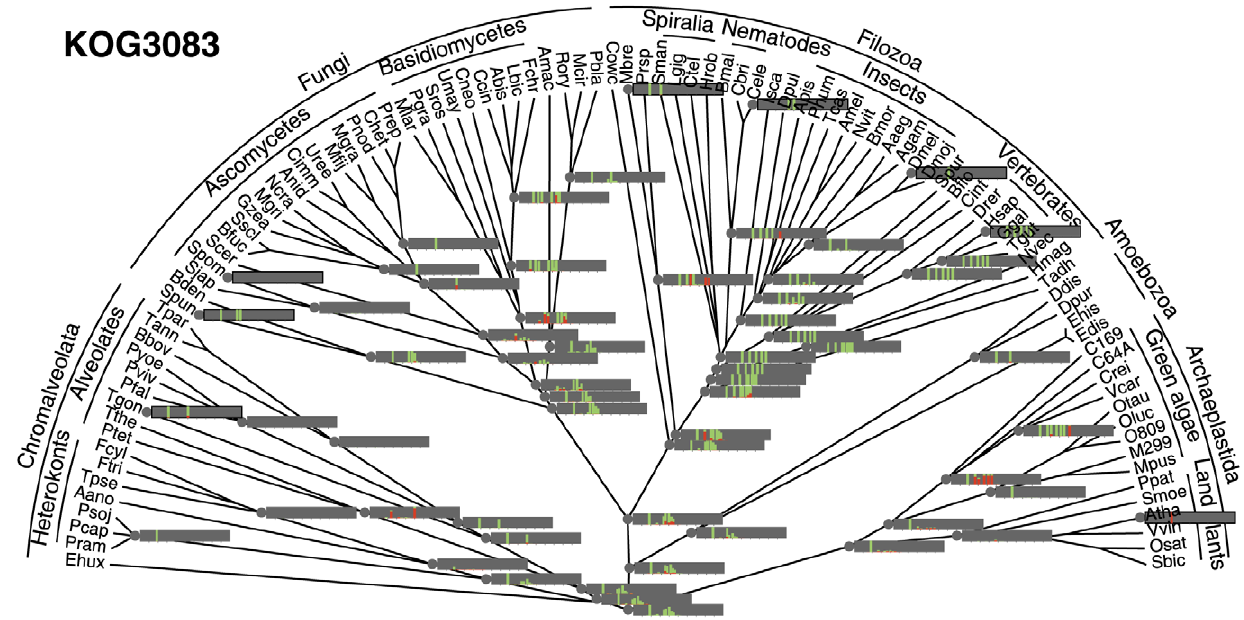
Figure 3. Inferred intron site histories in prohibitin orthologs (KOG3083). The tree from Figure 1 is used as the template for the reconstruction. Vertical bars are placed at intron sites proportionally along the X axis within the bars with respect to the underlying alignment. The height of green bars is proportional to the probability of intron presence; the height of red bars is proportional to the probability of intron gain in the lineage leading to the node.